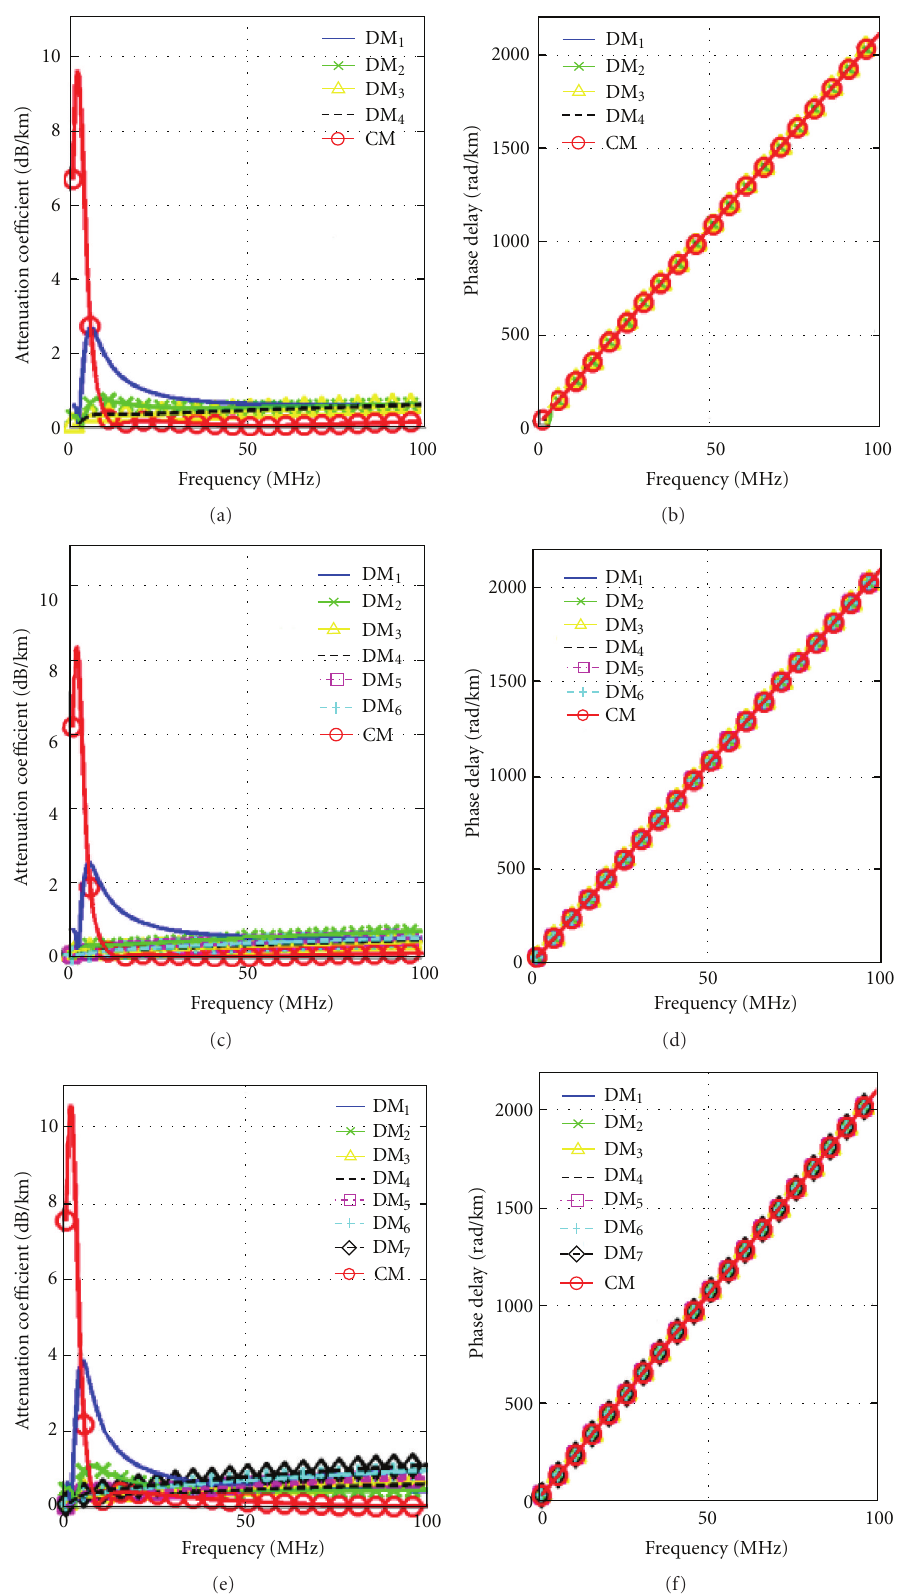
Figure 2: Frequency spectra of typical overhead HV multiconductor structures (the subchannel frequency spacing is equal to 0.1MHz). (a, b) Attenuation coe ffi cients and phase delays of 150kV single-circuit, respectively. (c, d) Attenuation coe ffi cients and phase delays of 275 kV double-circuit, respectively. (e, f) Attenuation coe ffi cients and phase delays of 400 kV double-circuit,